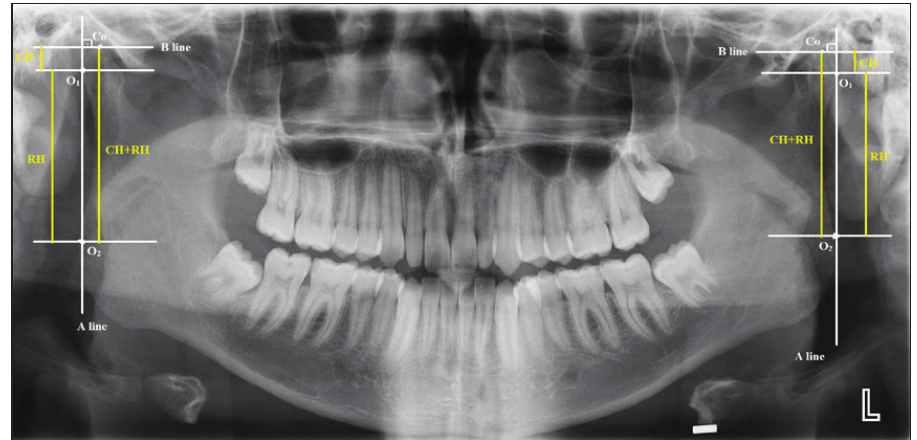
Figure 1. Linear measurements on panoramic radiographic